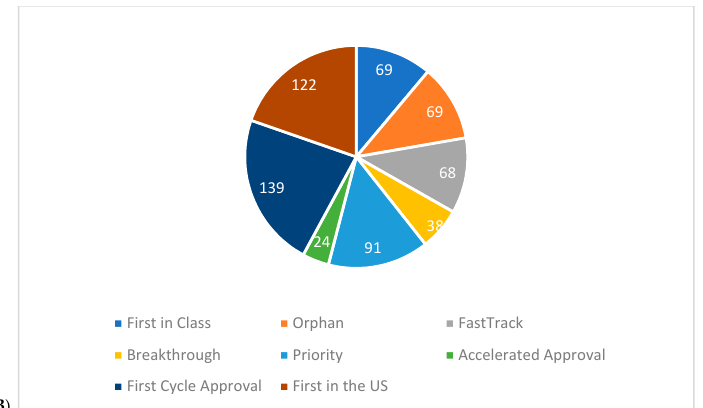
Figure 3. Total number of expedited development and FDA review programs granted to each newly approved NME from 2011–2017, segmented by company market capitalization: ( A ) small/mid cap; ( B ) large cap. Drugs can be associated with more than one program.